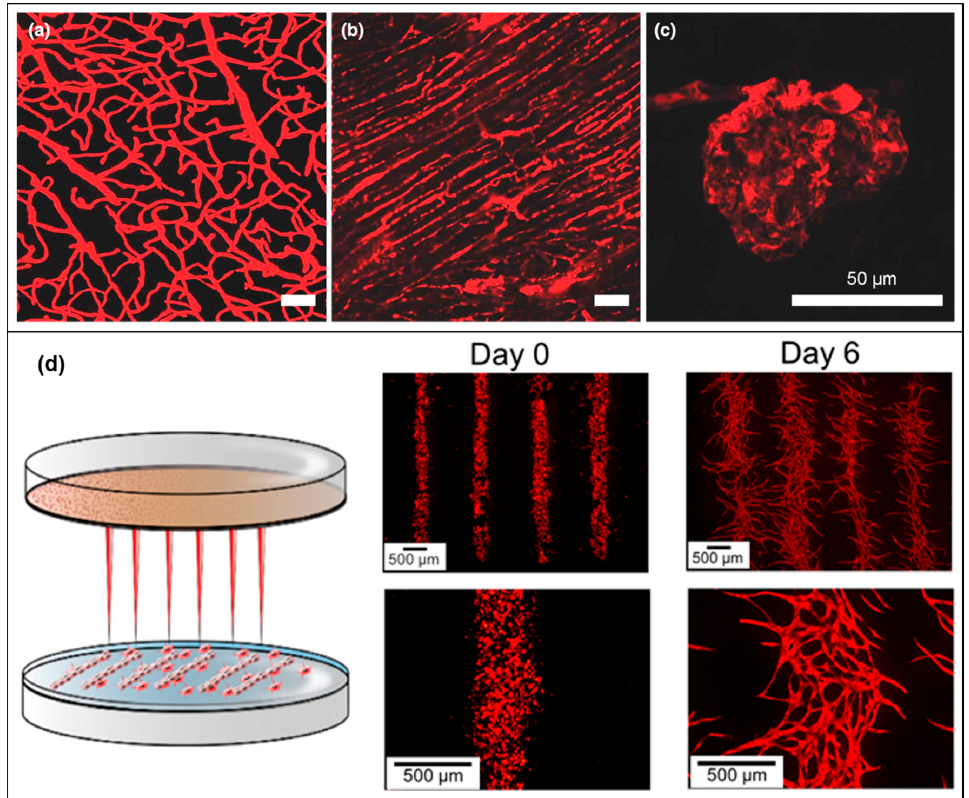
Figure 10. Examples of tissue dependent micro-vascular patterns. ( a ) Micro-vessels of a mouse brain following a space-filling morphology. ( b ) Micro-vessels of a mouse heart adjusting their morphology to align with cardiomyocytes. ( c ) Micro-vessels of mouse kidney organized as glomeruli (all are 50 µm). Reprinted from Understanding vascular development, Udan et al. Copyright (2012), with